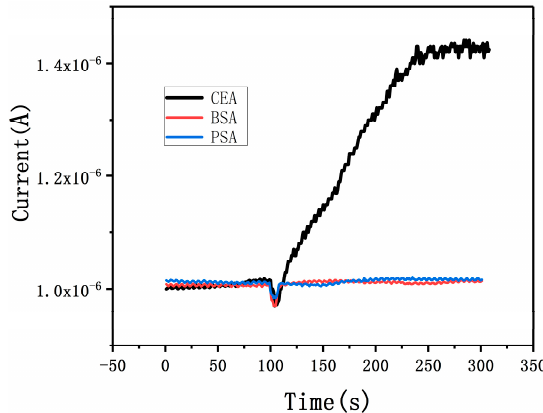
Figure 4. Characterization of the specificity of the anti-CEA-modified SiNW biosensor, displaying the time course of current for 10 mg/mL of BSA, 100 μ g/mL of PSA and 1 fg/mL of CEA.